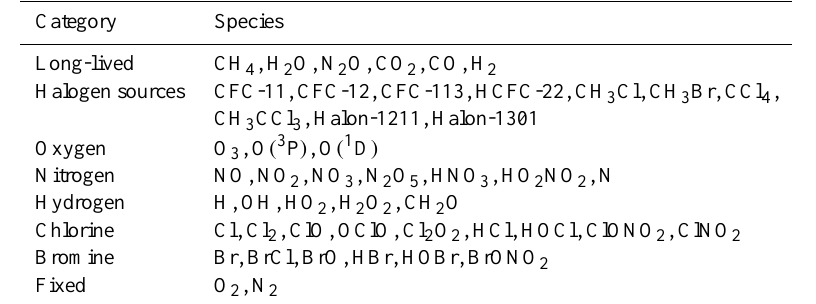
Table 1. Species considered in the chemistry